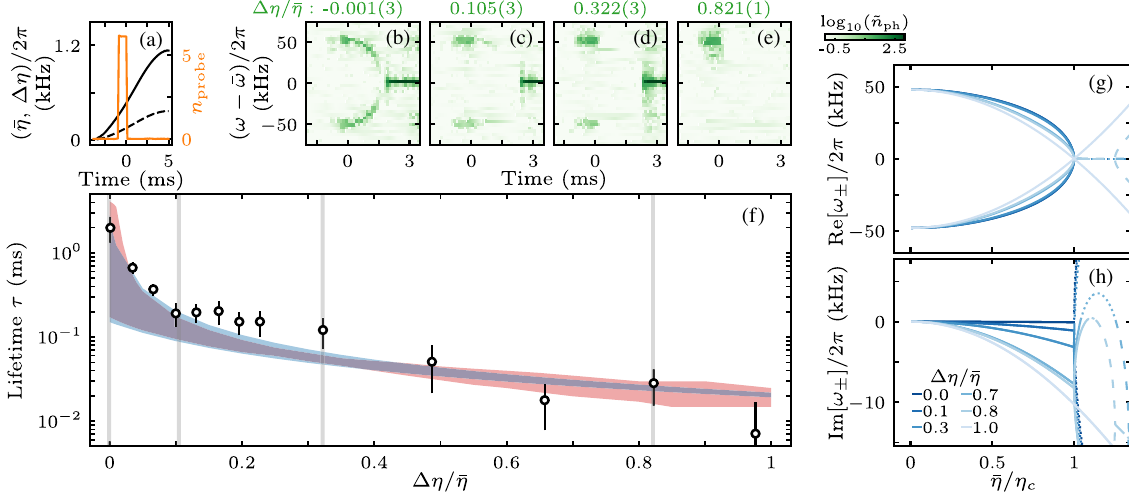
FIG. 3. Properties of the excited polariton. (a) Experimental protocol. While ramping up the couplings ¯ η (solid black line) and Δ η (dashed line) at constant Δ η = ¯ η , we populate the excited mode j 1 i using a weak excitation pulse along the cavity axis (orange line). Throughout this measurement, the maximal coupling ¯ η at the end of the ramp is 2 π · 1 . 16 ð 5 Þ kHz. (b) – (e) Representative heterodyne spectrograms for different ratios Δ η = ¯ η , showing the frequency-resolved mean number of photons ˜ n , as a function of the frequency and ph time. In (e), the large imbalance Δ η = η suppresses the superradiant phase transition. (f) Data points: measured lifetime of the induced excitations as a function of Δ η = ¯ η . The error bars showcase the maximum between the SEM and the time resolution of the photon traces ( 10 μ s). Blue shaded region: predicted lifetime from the analytical eigenvalues [cf. (g) and (h)], assuming a phenomenological atomic dephasing between 0 (upper bound) and 2 π · 500 Hz (lower bound); the latter is of the order of the s -wave scattering rate. Red shaded region: numerical simulation results. The values of Δ η = ¯ η shown in (b) – (e) are marked with gray vertical lines. (g),(h) Excitation eigenvalues of the system, linearized around the normal phase, and assuming zero atomic dephasing. Colors indicate different Δ η = ¯ η values; line shape indicates stable normal phase (solid), stable superradiant phase (dotted), and bistability (dashed). For the results − 2 π · 5 . 8 ð 1 Þ MHz, and δ 2 π · 2 . 0 ð 4 Þ presented here, N ¼ 9 . 6 ð 4 Þ × 10 4 , ω 0 ¼ 2 π · 48 ð 4 Þ kHz, Δ c ¼ probe ¼